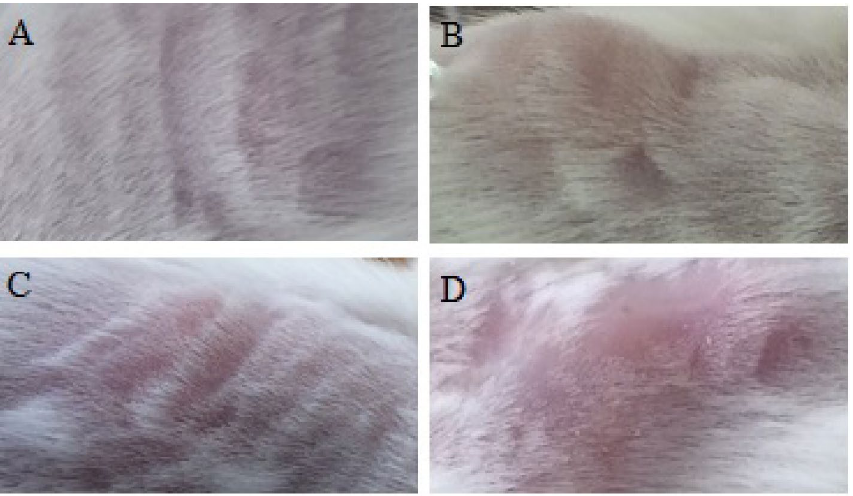
Figure 3. Reactions observed in the site of injection. ( A ) Normal skin; ( B ) Papule; ( C ) Erythema; ( D ) Papule plus